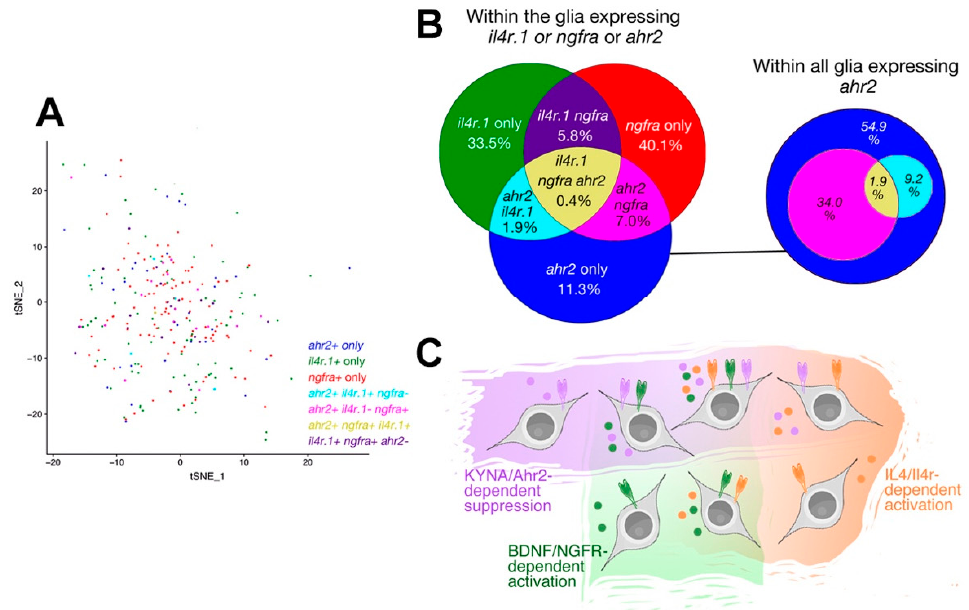
Figure 5. Single cell sequencing-based co-expression of il4r , ngfra , and ahr2 in adult zebrafish brain. ( A ) tSNE plot for astroglial cells in adult zebrafish telencephalon showing the cells expressing ahr2, il4r, ngfra and all possible triple combinations. ( B ) Venn diagram for the abundance of progenitor cells expressing different combinations. ( C ) Schematic depiction of various subtypes of neural stem cells that are responsive to multiple signaling pathways. KYNA/Ahr2-dependent regulation marks a new functional subtype of neural stem cells in zebrafish brain. Table 1. Transcriptome-wide association study (TWAS) for AHR-signaling-related genes in human LOAD